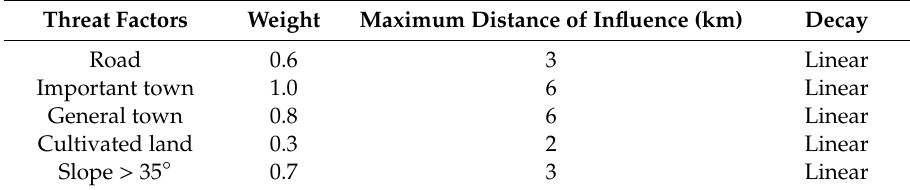
Table 3. Threat factor attributes.